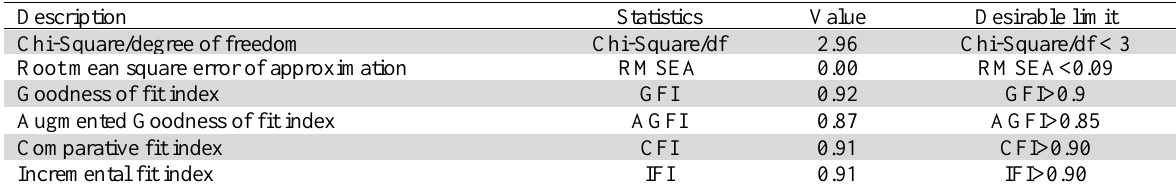
The summary of statistical